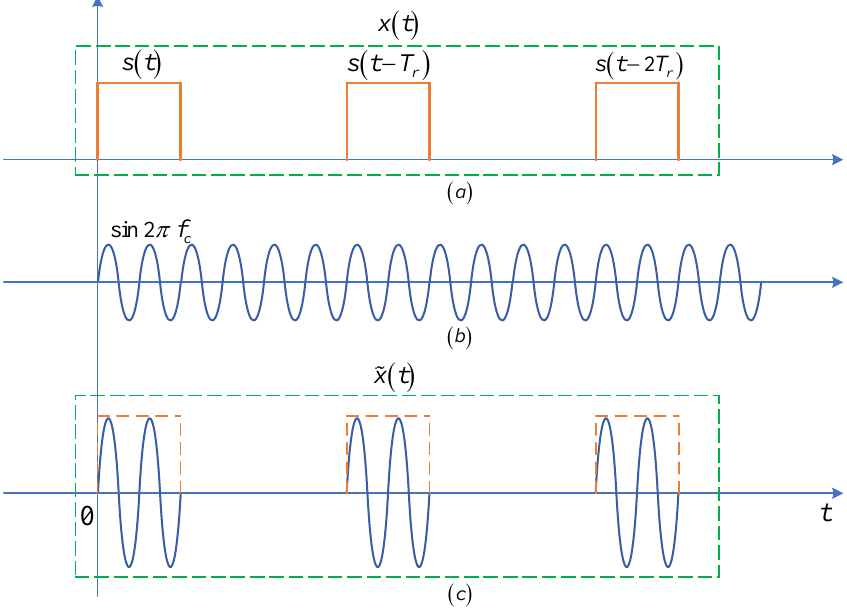
Figure 1. Illustration of the concept of a coherent transmitting signal. ( a ) Modulation pulse pair x ( t ) . ( b ) Carrier Signal. ( c ) Coherent transmitting